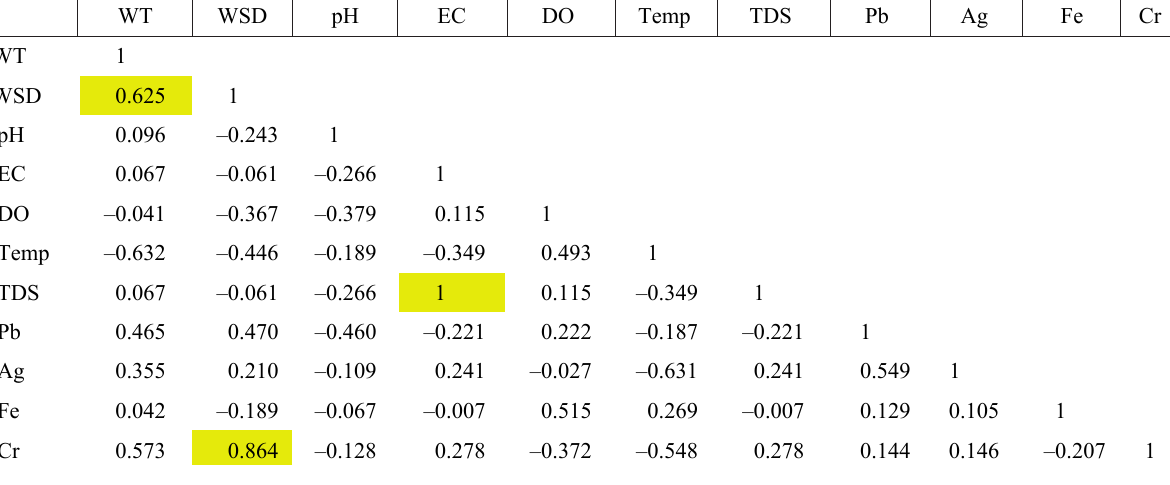
Table 2. Correlation matrix of HP water parameters in the study area, high correlations are shown in yellow